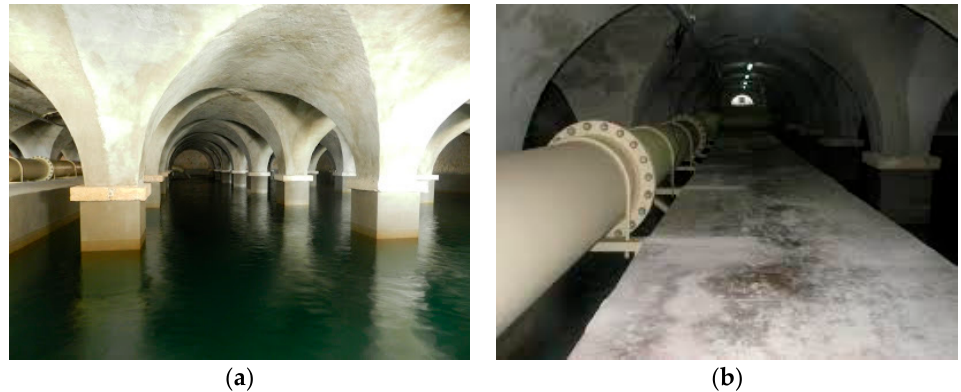
Figure 6. The municipal aqueduct of St. Ioannis in Chania: ( a ) Central tank; and ( b ) part of distribution water network.